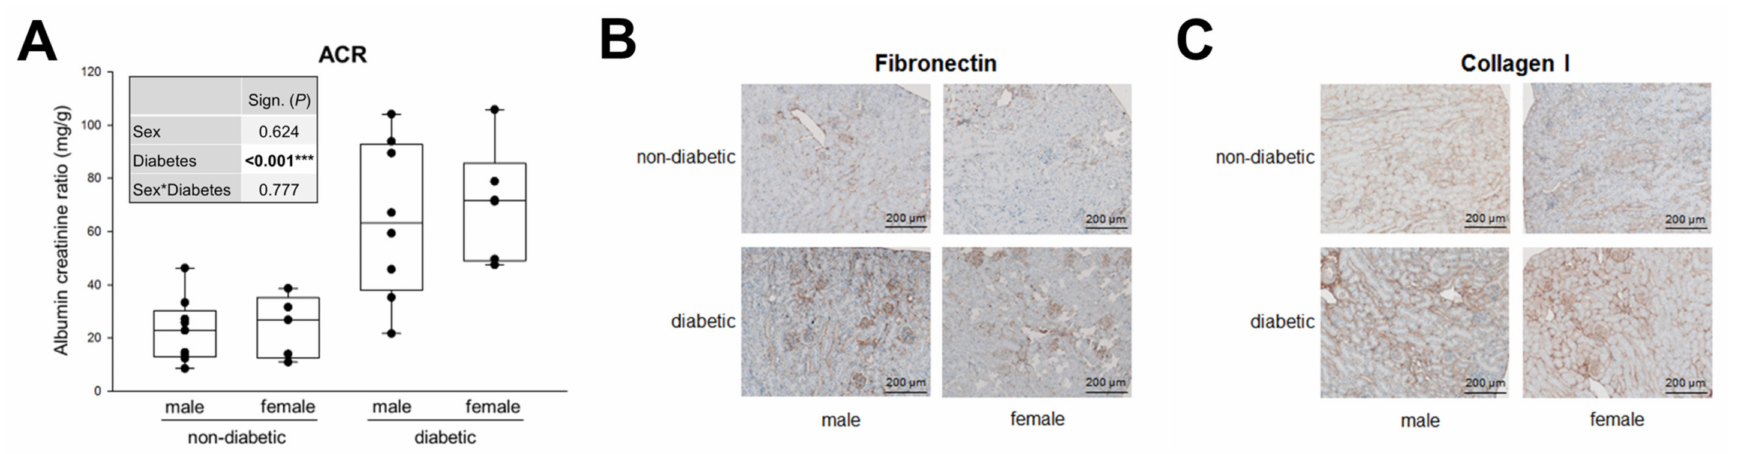
Figure 1. Microalbuminuria and TIF in diabetic mice. ( A ) Urinary albumin-to-creatinine ratio (ACR) from 24 h urine. Each point on the graph represents an individual mouse ( n = 9 / 5 / 8 / 6). The significance, shown in the table (graph insert) was assessed using two-way ANOVA with sex (male or female) and diabetes (non-diabetic or diabetic) as the two factors. Sex, Diabetes: main e ff ect of sex / diabetes, respectively. Sex*Diabetes: interaction (determines whether the one main e ff ect depends on the level of the other main e ff ect). ( B ) Fibronectin. Representative images of fibronectin immunohistochemistry (magnification: 100 × ). ( C ) Collagen I. Representative images of collagen type I immunohistochemistry (magnification: 100 × ). *** P ≤